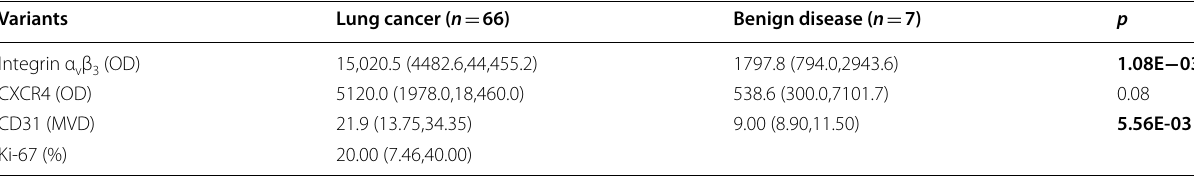
Table 2 Immunohistochemical results of lung cancer and benign disease